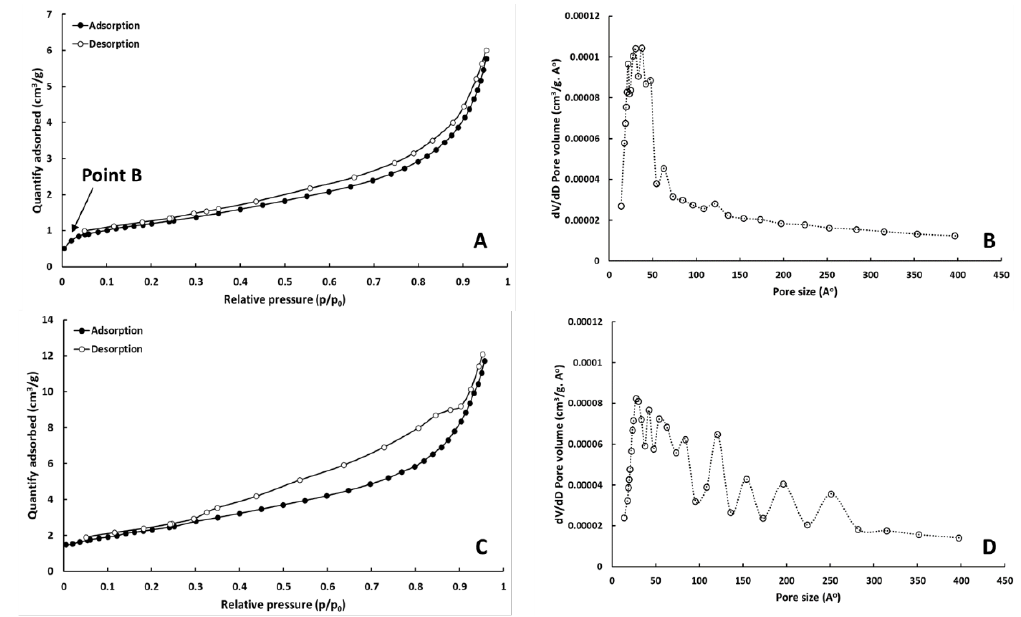
Figure 5. The N 2 gas sorption/desorption isotherm loop for ( A ) untreated and ( C ) polymer-treated tailings plus a histogram of the pore size distribution of ( B ) untreated and ( D ) polymer-treated tailings.